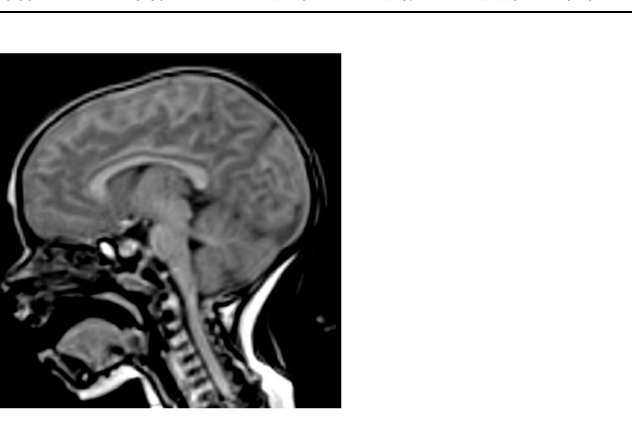
Table 1. Hormonal evaluation of anterior pituitary function in the affected child. GH: growth hormone. IGF1: insulin-like growth factor 1. TSH: thyroid stimulating hormone. PRL: prolactine. The immuno-chemiluminometric assay measured all hormones.